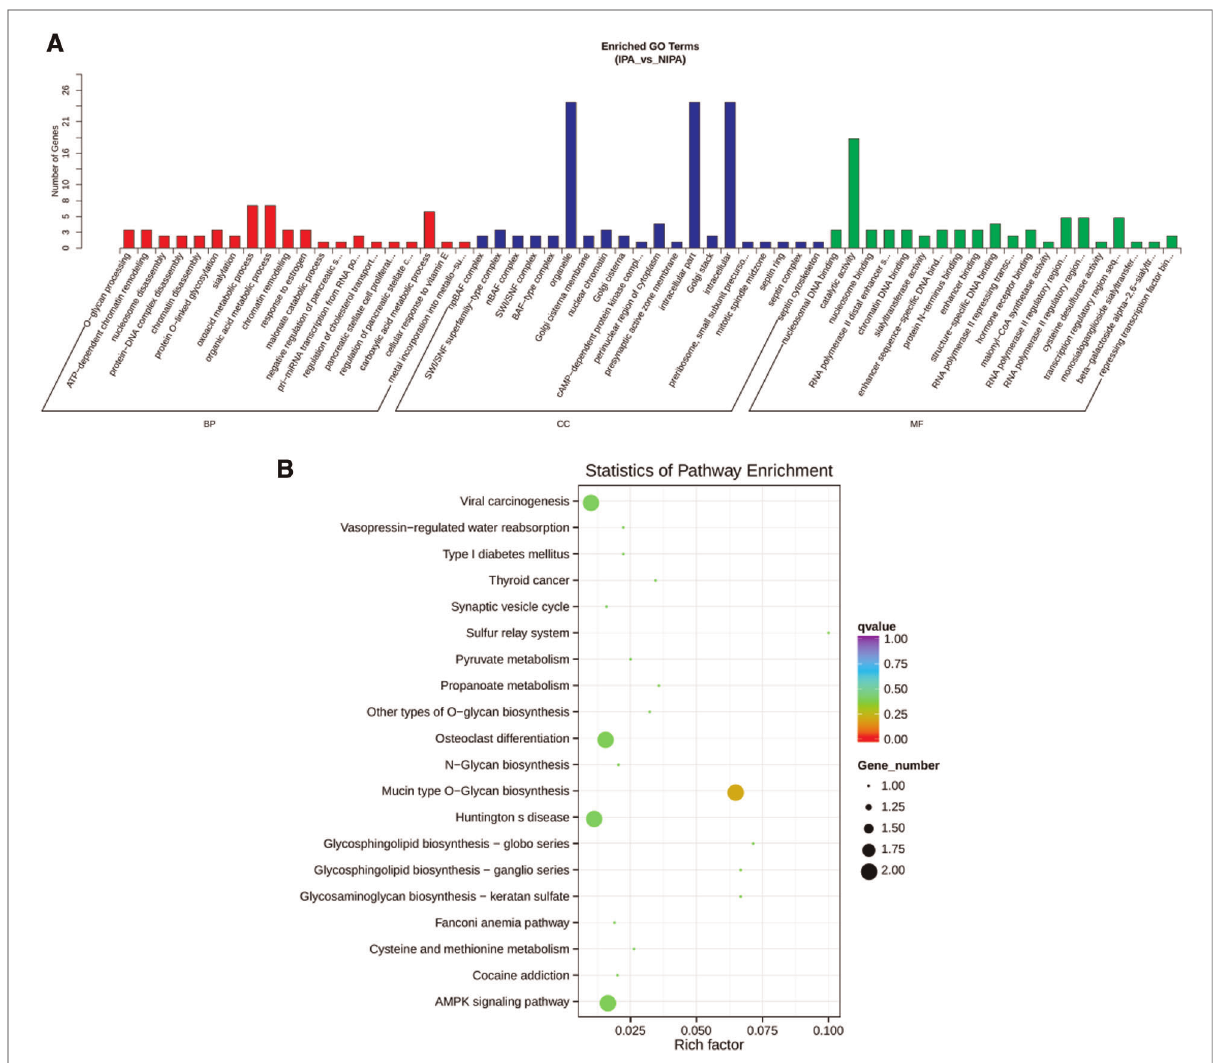
FIGURE 6 miRNA regulatory network target gene enrichment analysis. ( A ) GO function enrichment bar chart of the top 20 enriched items. Abscissa denotes GO entry, BP, biological process; CC, cellular component; MF, molecular function are represented by different color bars; ordinate is the number of genes enriched by GO entry. ( B ) KEGG pathway enrichment bubble diagram of top 20 enriched pathway